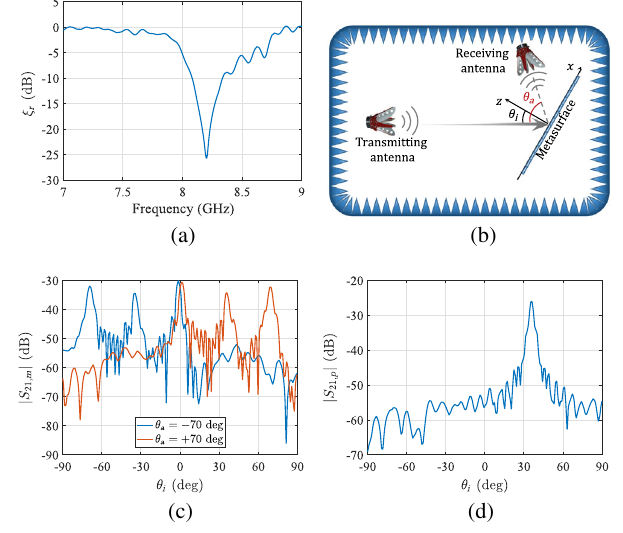
FIG. 10. (a) Efficiency of retroreflection from the power splitter under normal illumination. The splitter is matched for normal incidence at 8.2 GHz. (b) Illustration of the experimental setup for the power splitter (top view). (c) Signals measured by the receiving antenna versus the orientation angle of the metasurface θ i for two positions of the receiving antenna. (d) Signal from a reference metal plate ( θ a ¼ þ 70